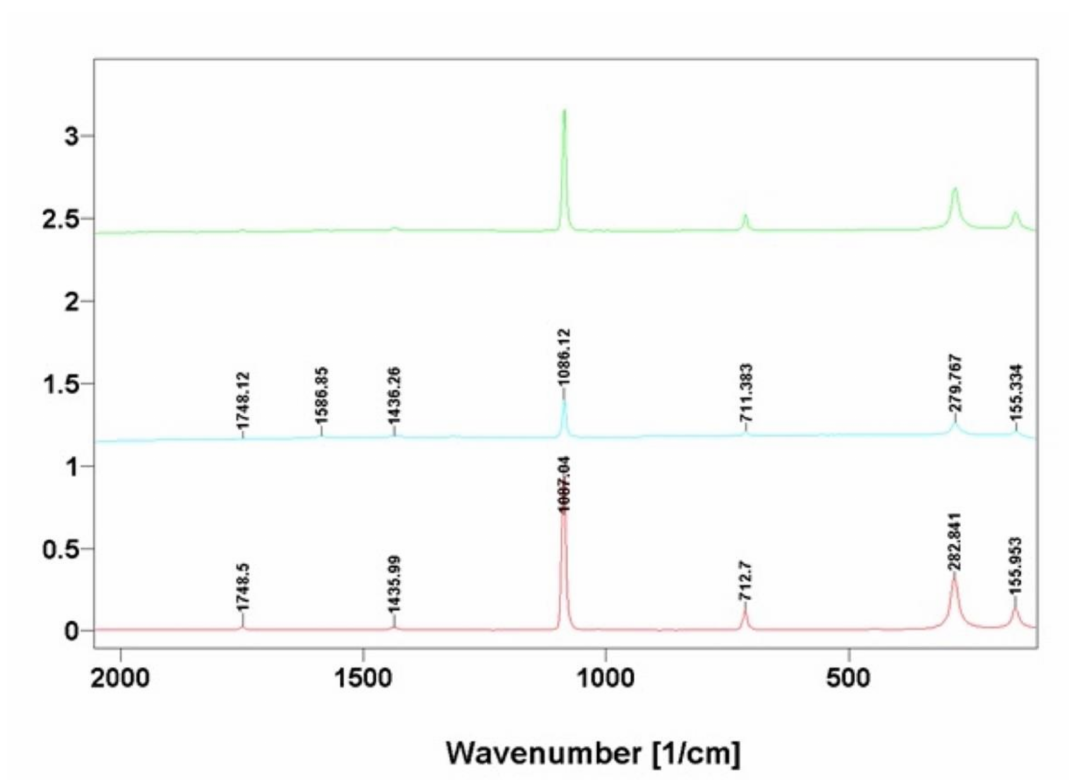
Figure 8. Comparative Raman spectra of calcite standard (blue line) with that of nanocrystalline phases isolated from skeletal fibers of I. basta demosponges collected near Guam (USA) (red line) and in coastal waters of Australia (green